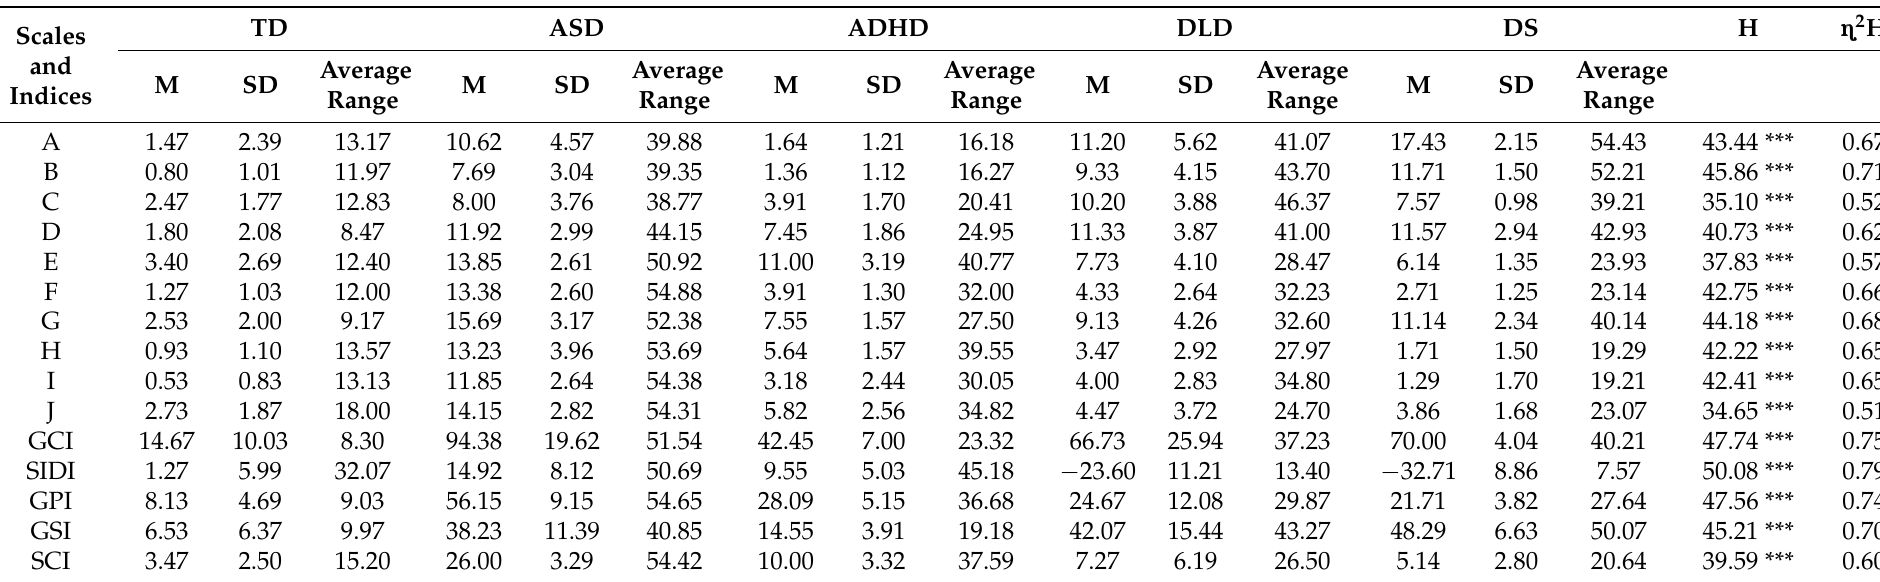
Table 4. Means (M), standard deviations (SD) and average ranges of the five groups at preschool age and analysis of the differences through the Kruskal–Wallis test.